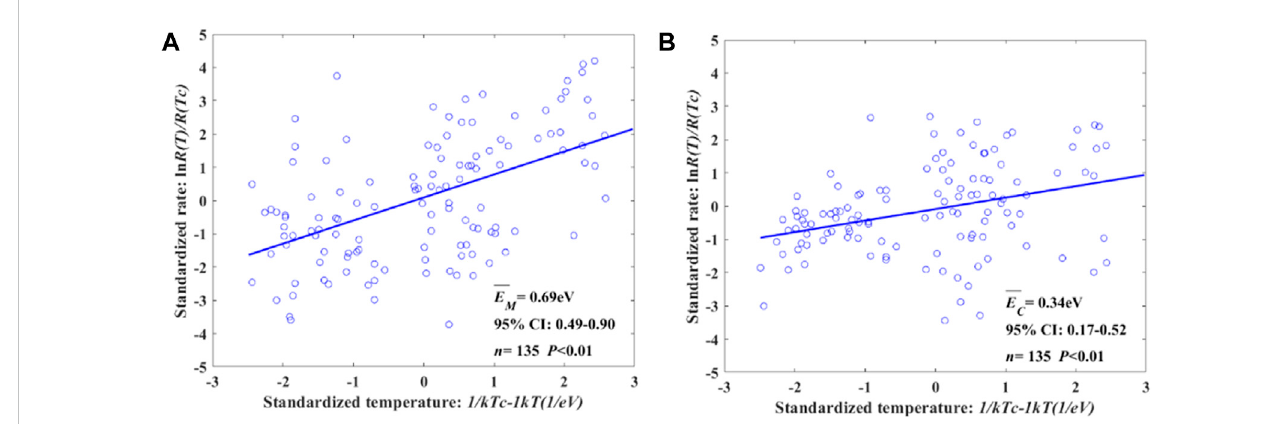
FIGURE 4 Temperature dependence of CH 4 (Figure 4A) and CO 2 (Figure 4B)